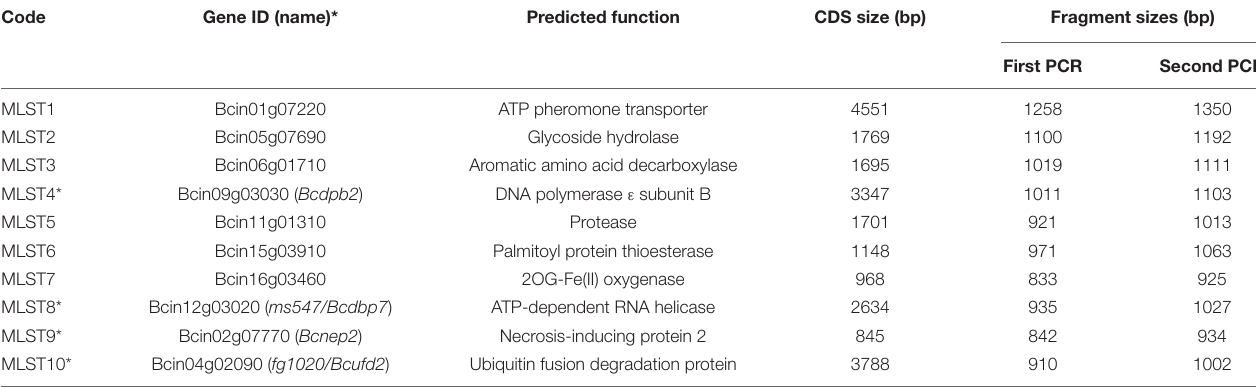
TABLE 2 | Genes used for MLST of Botrytis